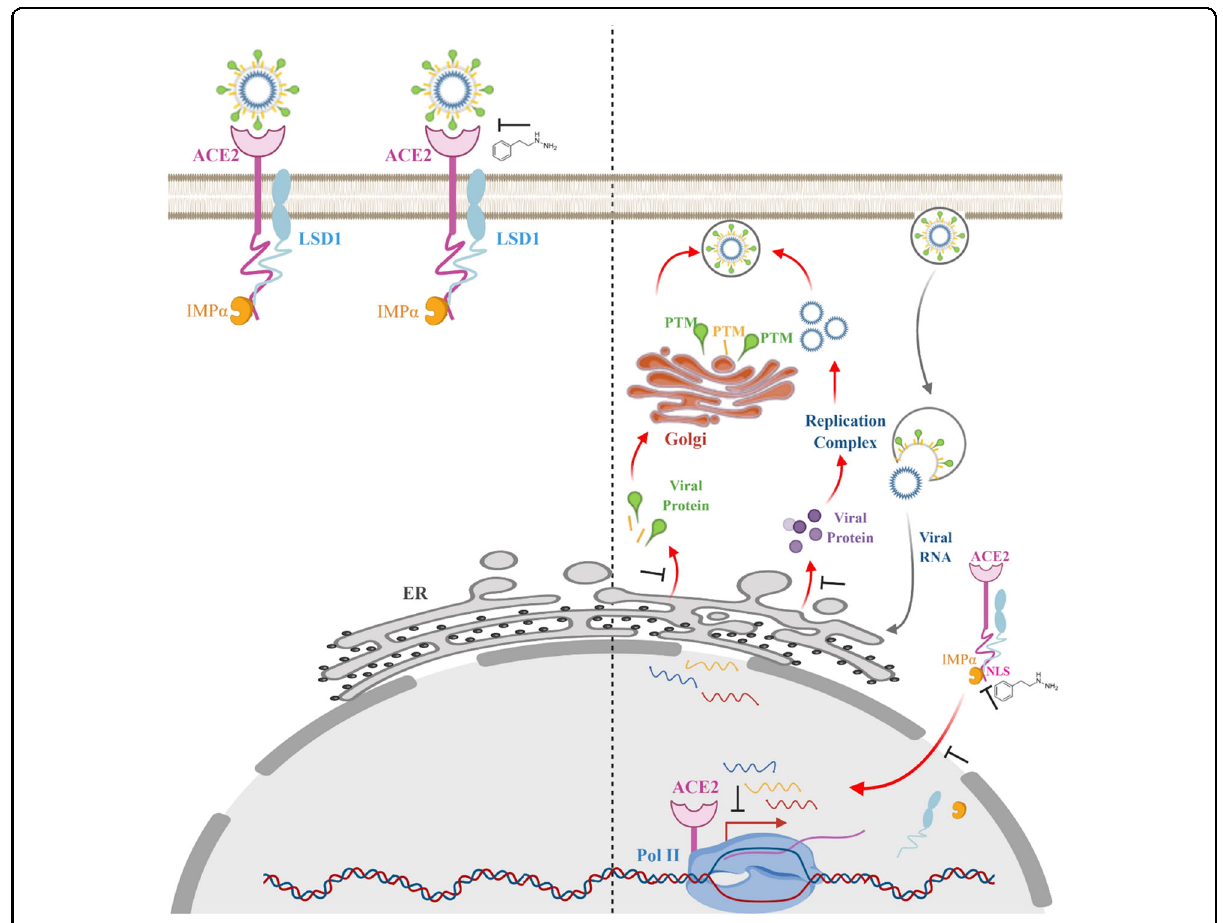
Fig. 6 A summary model of SARS-CoV-2/ACE2/LSD1 interactions. Our data support a model in which: (Left) at the cell surface, SARS-CoV-2 entry relies on LSD1-dependent demethylation of ACE2, which is required for ACE2/SARS-CoV-2 spike binding. LSD1 inhibition therefore reduces viral entry via ACE2, especially LSD1 catalytic inhibitors such as GSK. In addition, our novel ACE2 peptide inhibitors, which compete with binding to SARS-CoV-2 spike protein, also block viral replication. (Right) Intracellularly, NACE2i blocks LSD1/ACE2 binding at cytoplasmic tail, and this change in protein – protein interactions might consequently inhibit LSD1 ’ s demethylation activity. IMP α binds to the cytoplasmic tail of non-methylated ACE2 to mediate nuclear translocation and Pol II association to regulate gene expression. Therefore, NACE2i blocking IMP α /ACE2 binding impact ACE2-Pol II nuclear co-localization, which is required for SARS-CoV-2-related transcription, to reduce viral